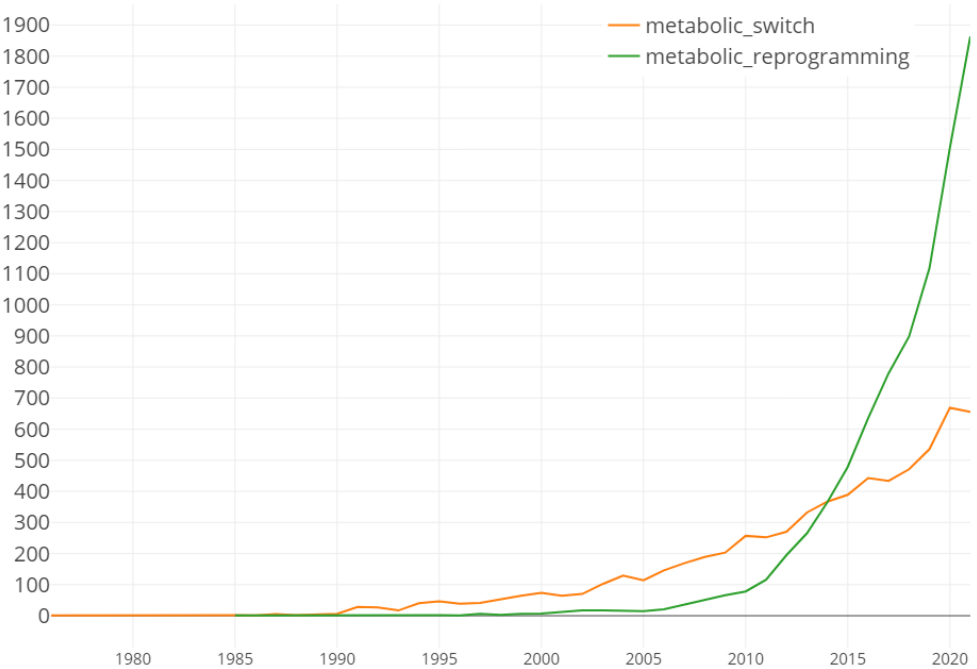
Figure 5. Evolution of the number of publications associated with the terms metabolic reprogramming and metabolic switch . Results obtained from the World of Science database from their title, the abstract or in keywords.